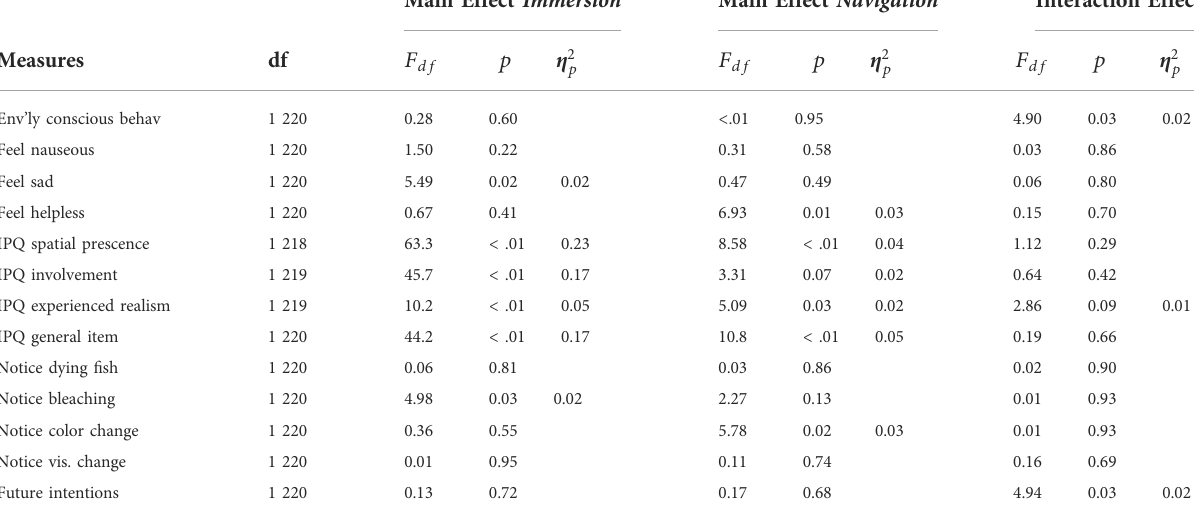
TABLE 3 Two-factorial analyses of